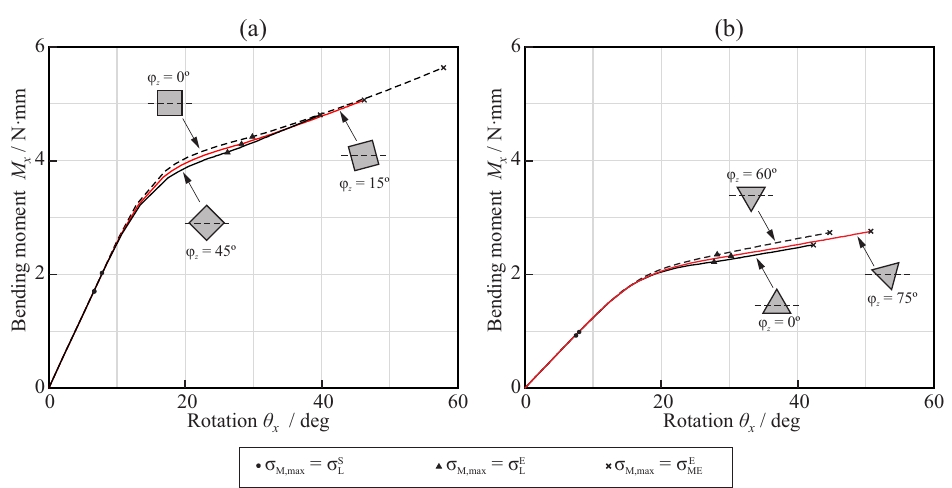
Figure 6. Bending moment–rotation relationships for the bending analysis of endodontic files with p z = 4 mm: squared cross-section ( a ) and triangular cross-section ( b ).